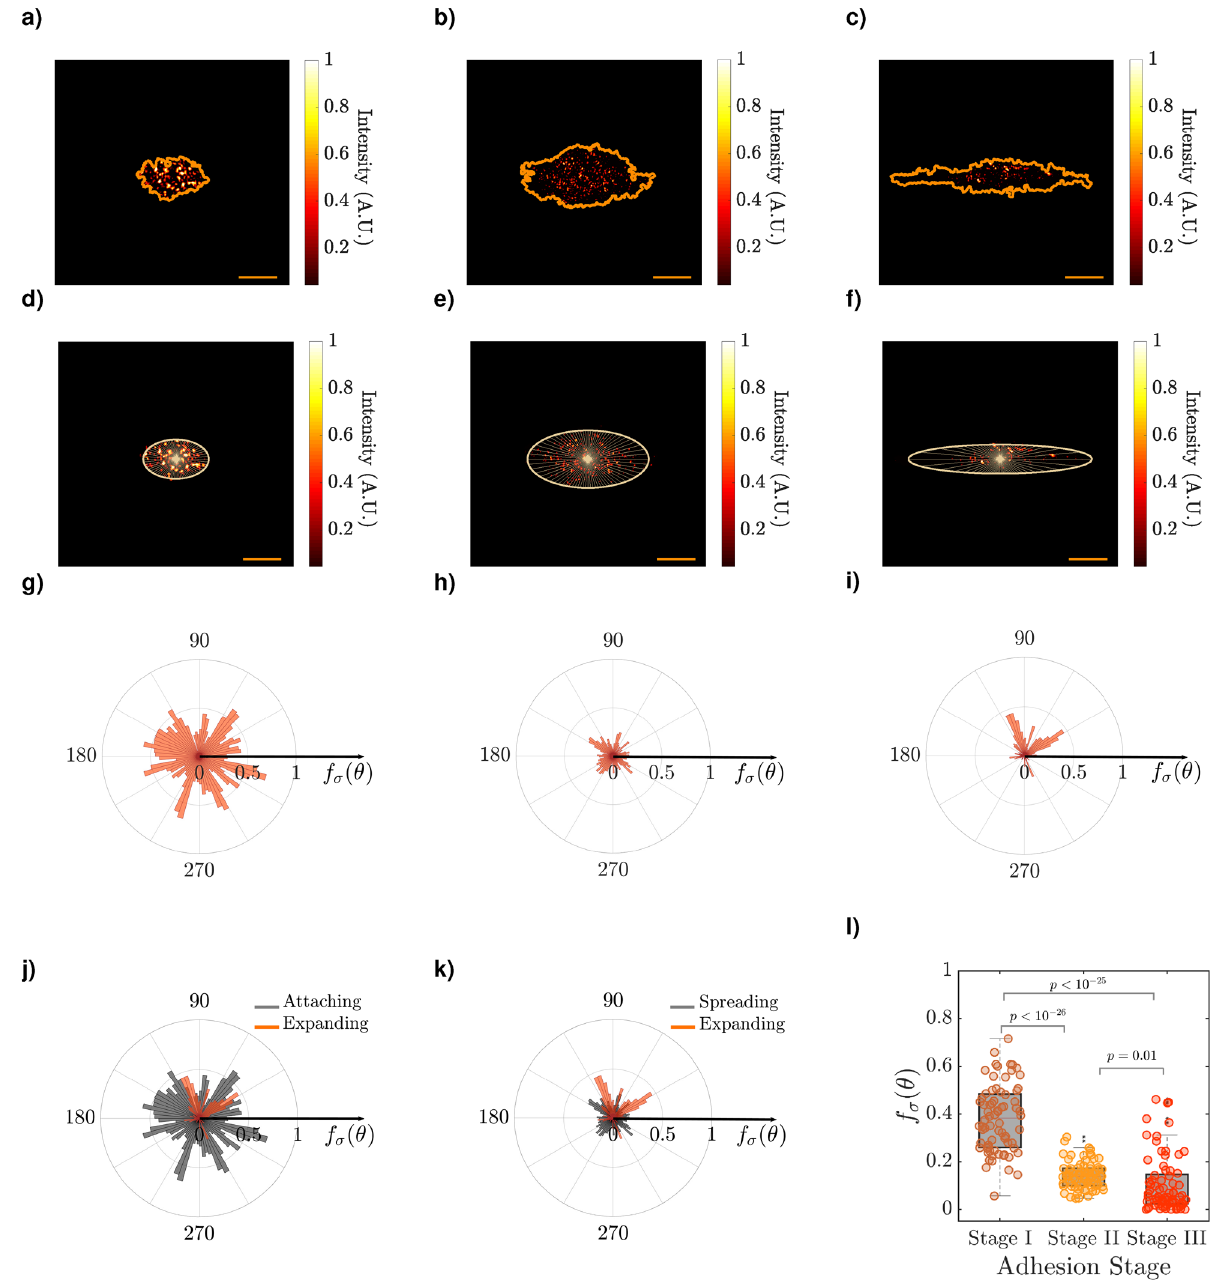
Figure 2. Polar profile of F-actin patches in the cell’s contact-region. TIRFM-images of F-actin patches (bounded to phalloidin TM 633 molecules) in single melanoma cells ( a – f ), and the polar plot of the probability- (mapped)-distribution of F-actin patches, f σ (θ) , in the contact-region of cells ( g – i ), where cells are at the attaching stage ( a , d , g ), the spreading stage ( b , e , h ), and the expanding stage ( c , f , i ). The color bar shows the magnitude of normalized-intensity, where I = 1 and I = 0 denote the highest and lowest intensity per pixel. ( j ) The overlay of the distribution of the F-actin patches of two cells, which are at the attaching stage and the expanding stage. ( k ) The overlay of the distribution of the F-actin patches of two cells, which are at the spreading stage and the expanding stage. ( l ) Distribution of f σ (θ) per sector (72 sectors) of three melanoma cells (panels (a)-(c)), which are at different adhesion stages of the attaching stage (stage I), spreading stage (stage II), and expanding stage (stage III). The scale bar in images is 5 µ